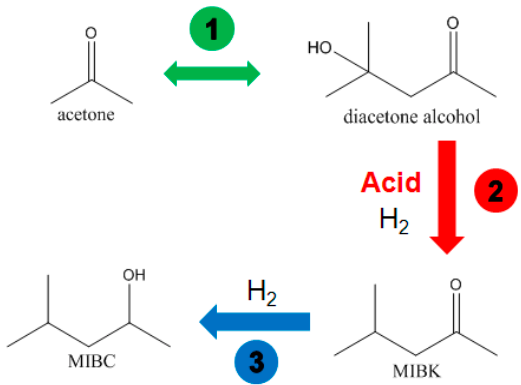
Figure 6. Schematic representation of generation process of byproduct MIBC. Reproduced from [18] with permission from Jiang H., Sci. China Chem.; published by Springer, 2016.